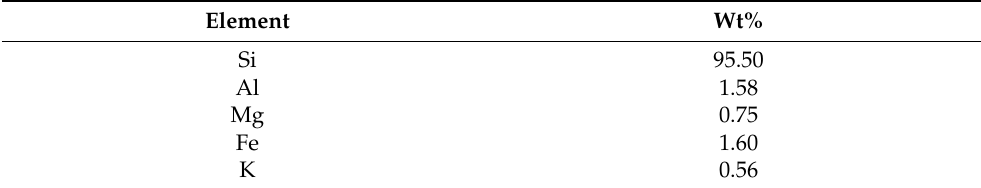
Table 1. EDS elemental analysis of